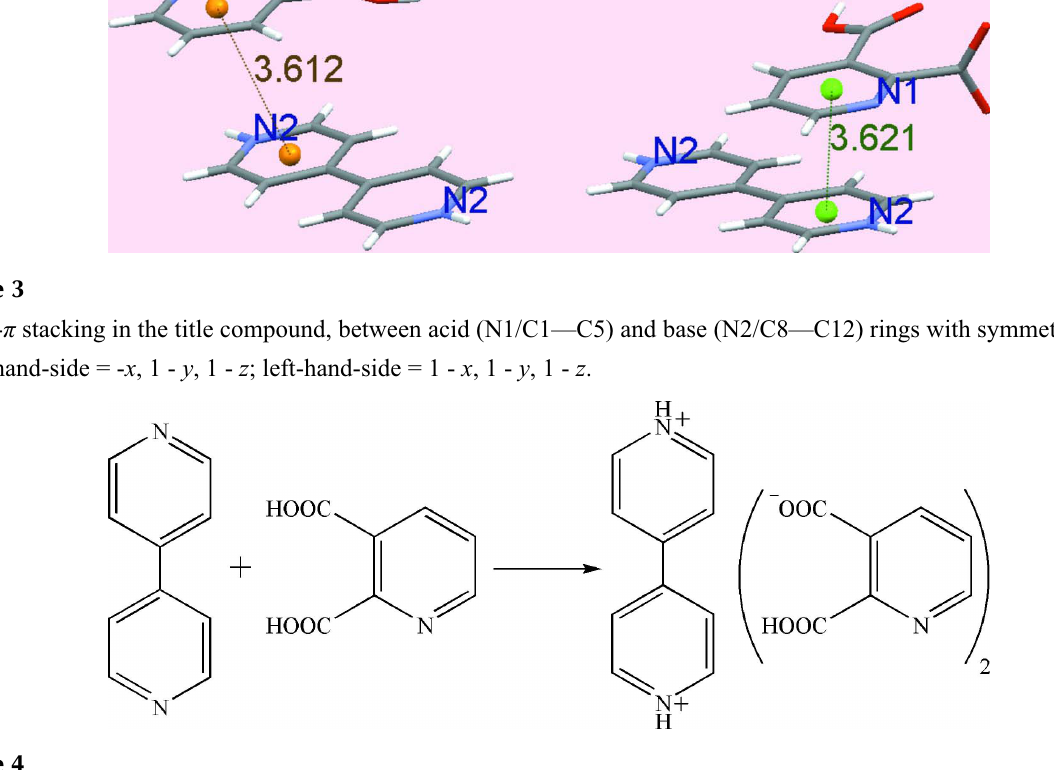
The formation of the title